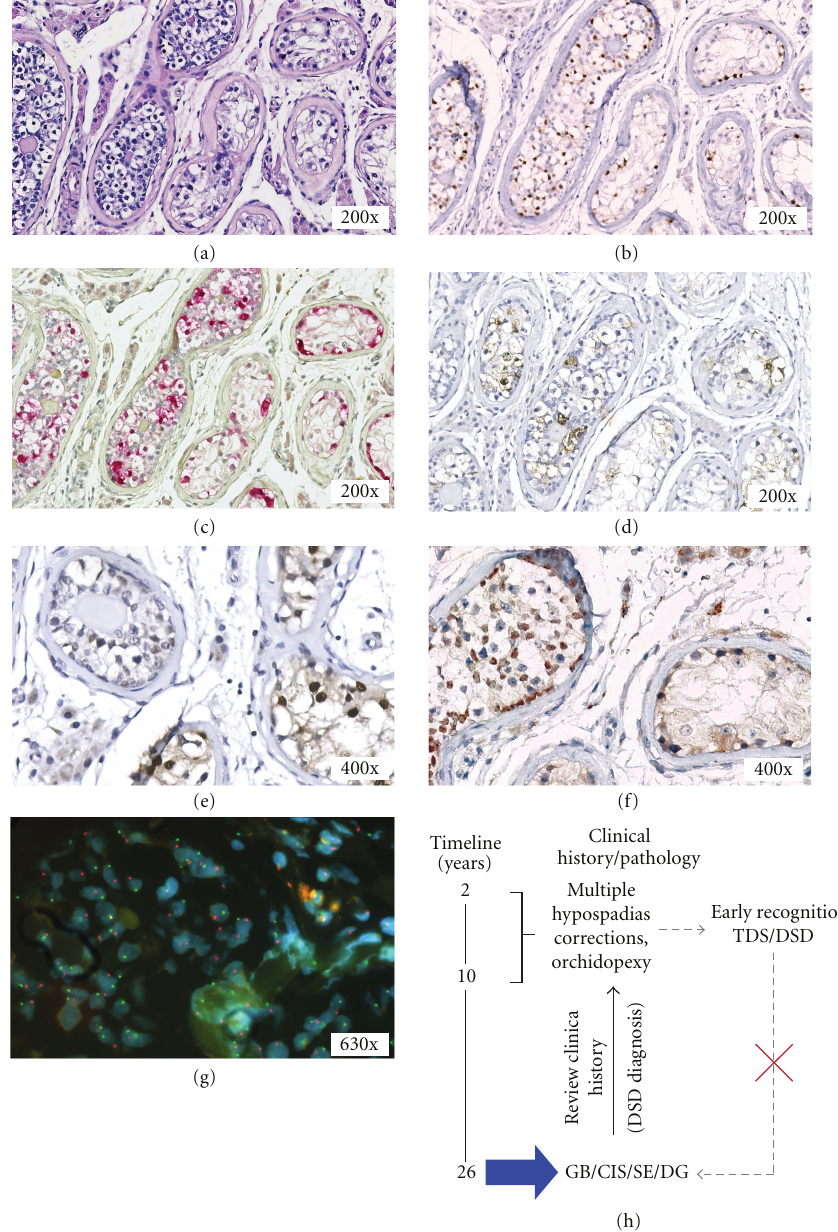
Figure 1: Immunohistochemical staining and fluorescent in situ hybridization (FISH) of the gonadoblastoma and carcinoma in situ lesions of patient 1. (a) Representative hematoxylin and eosin staining. The germ cells present in the GB and CIS stain positive for (b) OCT3/4 (brown), (c) TSPY (red), and (d) SCF (brown). (e) The supportive cells in the CIS lesion are SOX9 positive (brown staining) and are negative for FOXL2. (f) In the GB, the supportive cells stain positive for FOXL2 (brown staining) and are negative for SOX9. (a–f) In every image the GB lesion is shown on the left side (embryonic germ cells intermixed with granulose-like supportive cells), CIS containing seminiferous tubules on the right side (CIS cells associated with Sertoli cells on the basal lamina). Magnification 200x and 400x for all. Slides (b)–(f) are counterstained with hematoxylin. (g) Representative FISH with Y-centromere-specific probe (shown in red) and X-centomere-specific probe (shown in green). Magnification 630x. (h) Schematic representation of the di ff erent moments in time of clinical intervention, blue arrow, identification of a malignant type II germ cell tumor, together with GB and CIS as precursor lesions at the age of 26 years. Review of the clinical history showed hypospadias and cryptorchid testes, signs of TDS/DSD which were not recognized at an early age. Grey-dashed arrows; early recognition of TDS/DSD could have allowed early detection and treatment of the malignancy, thereby, preventing the need for additional systemic